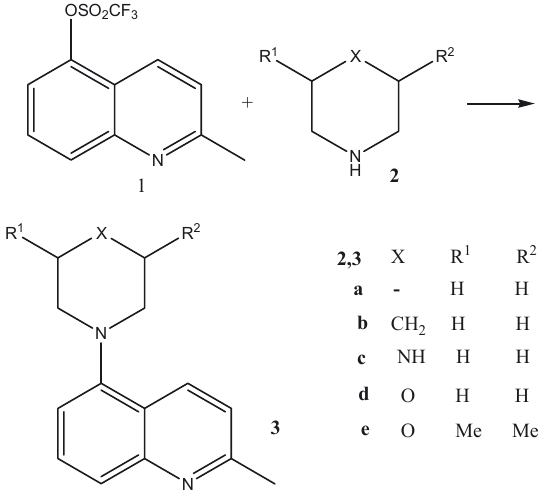
Scheme 1. A general reaction scheme of quinaldin-5-triflate with select General Reaction Procedure for the Amination of 2-Methylquinoline-5-triflate.